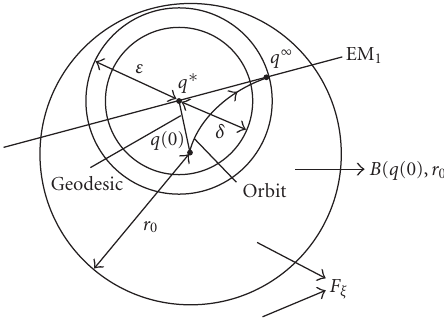
Figure 5: Definition of the Riemannian ball B ( q ∗ , δ ). Any orbit starting from B ( q ∗ , δ ) converges to EM 1 ∩ B ( q ∗ , ε ) .